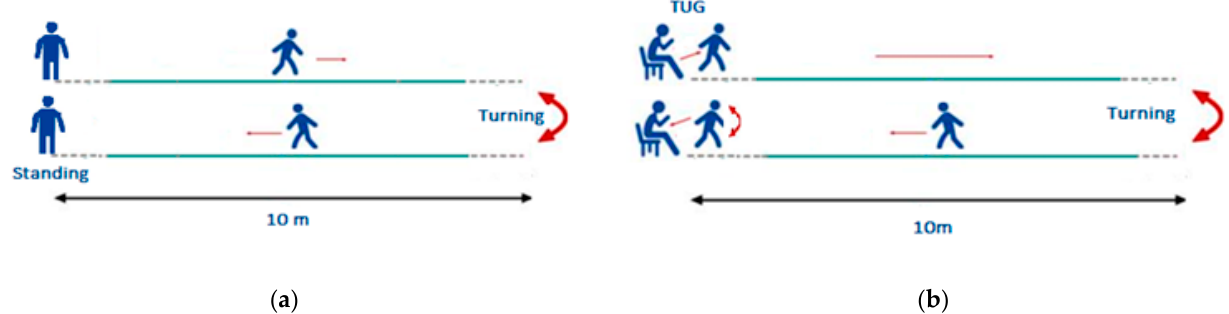
Figure 3. Left figure ( a ) The Walking Straight Test, and right figure ( b ) The Timed Up and Go test.